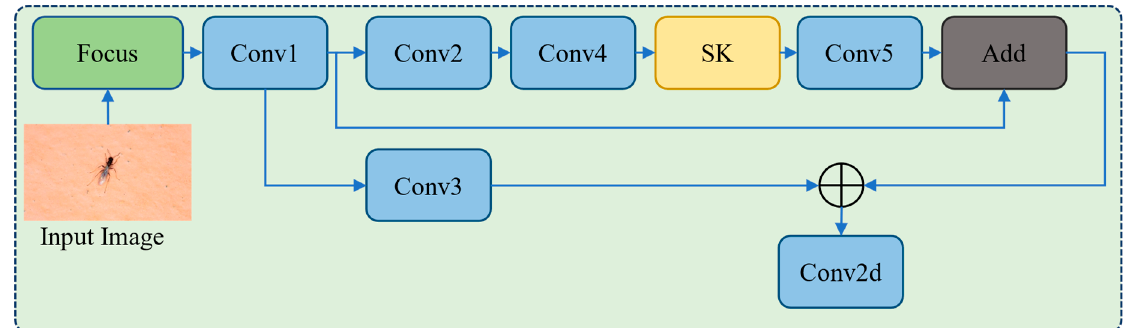
Figure 2. The Backbone part of the proposed work with the extended CSP module.